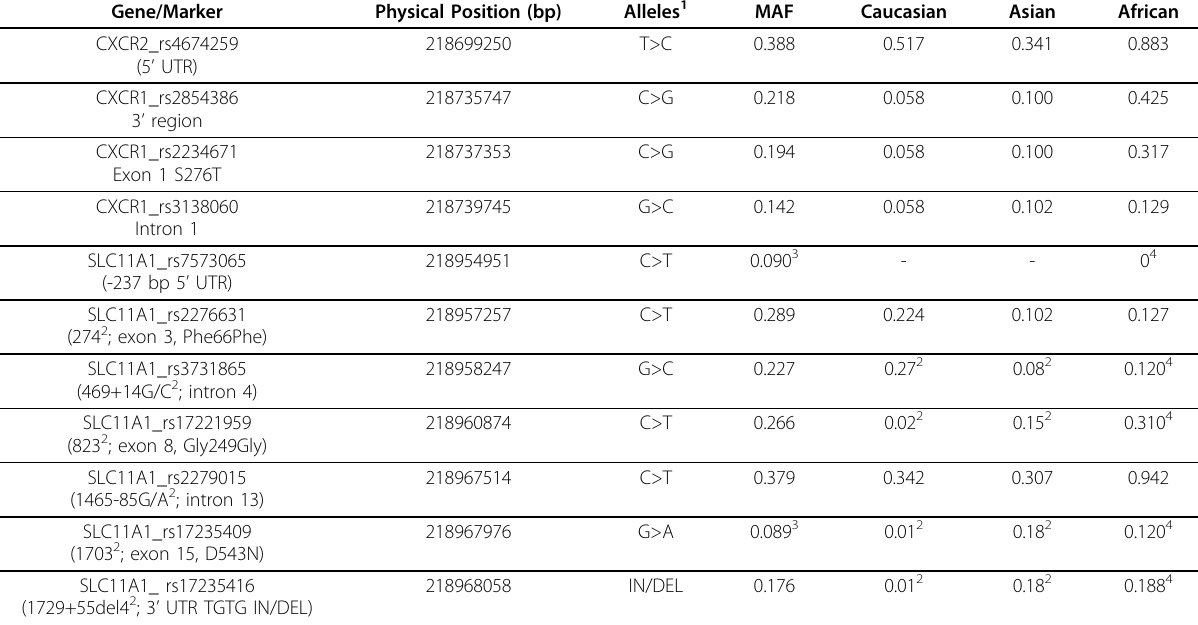
Table 1 Information on the polymorphic markers genotyped for CXCR1 , CXCR2 and SLC11A1 .